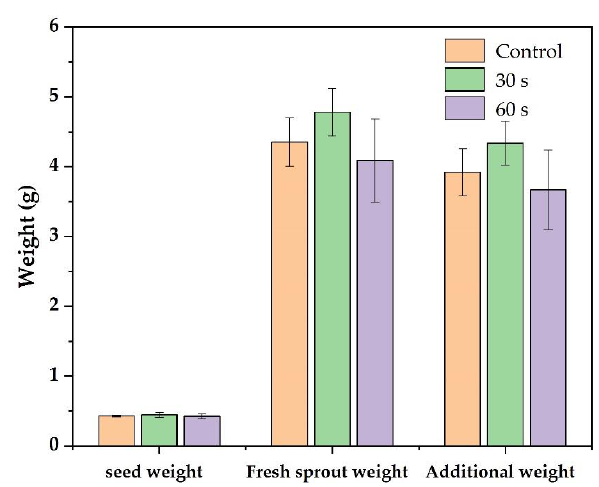
Figure 11. Comparison of the weight of sprouts of treated and untreated broccoli seeds after seven days of cultivation.